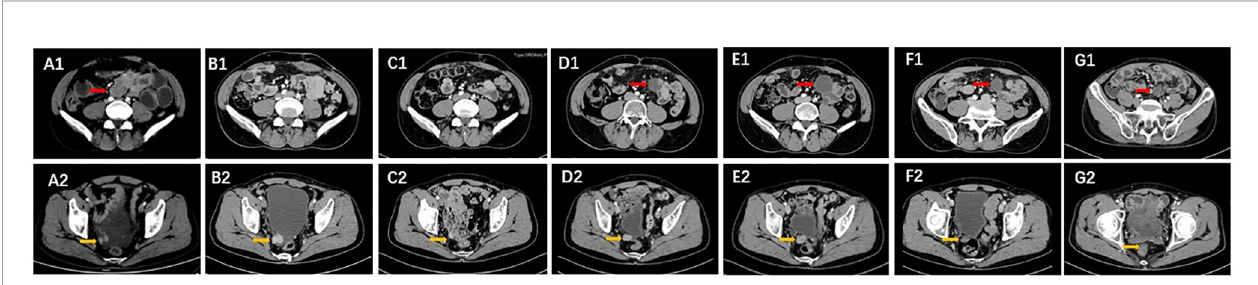
FIGURE 1 | The lesions indicated by arrows at different time points. (A1, A2) Lesions were observed before surgery in the CT images in April 2019. (B1, B2) Images after surgery in May 2019. (C1, C2) Partial remission of the lesions after two cycles of CHOP. (D1, D2) New lesions can be seen in March 2020 after a PFS of 2 months. (E1, E2) The lesions were expanded after two cycles of ABVD chemotherapy. (F1, F2) The lesions shrunk after 3 cycles of sintilimab and lenvatinib. (G1, G2) Partial remission of the lesions were shown after 6